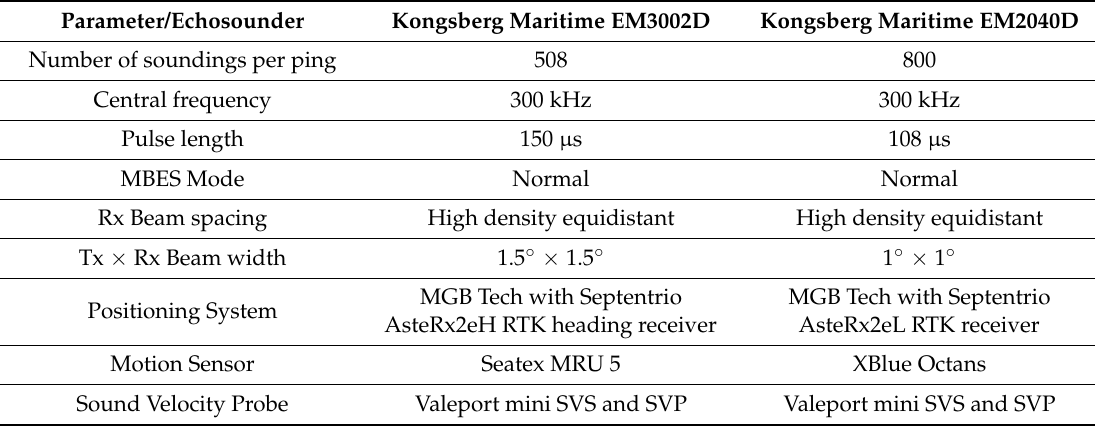
Table 1. MBES specifications and main settings, and associated ancillary